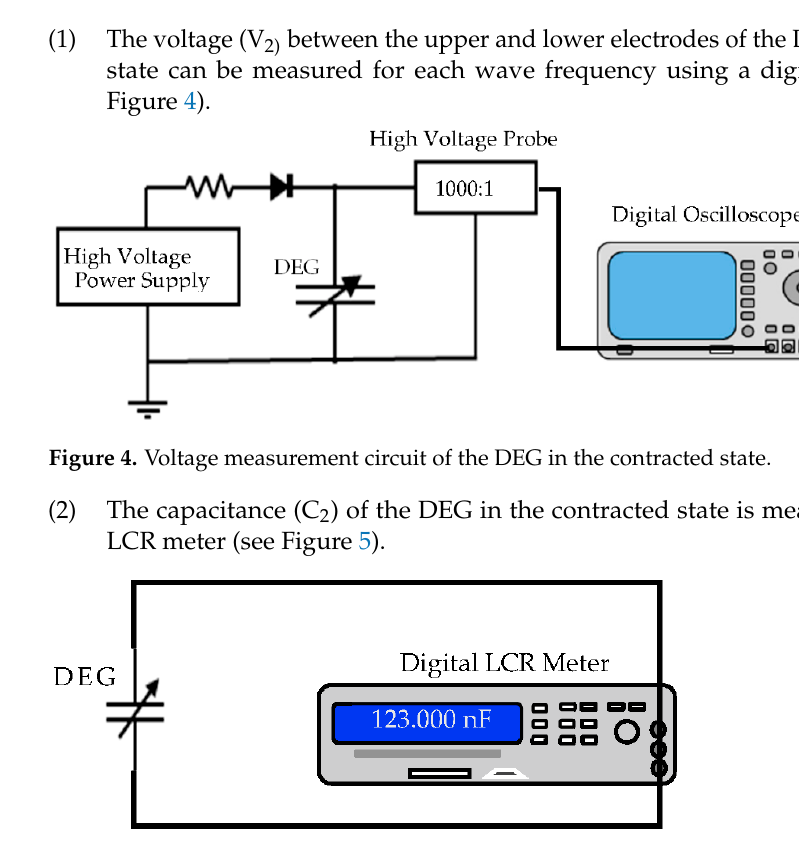
Figure 6. The 1000 V DC/DC converter. Figure 7. The 1500 V DC/DC converter. (2) Fairchild DC/DC converter (12 V output)